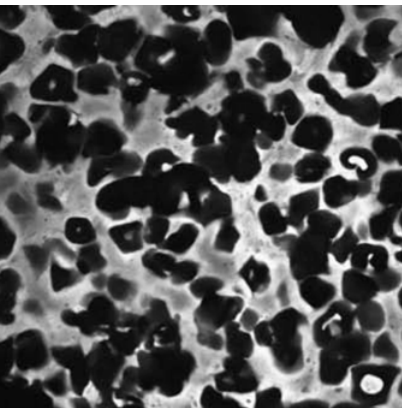
Fig. 2. Randomly structured microstructure of a typical bio- polymer composite using SCLM. Image size about 140x140 µm².